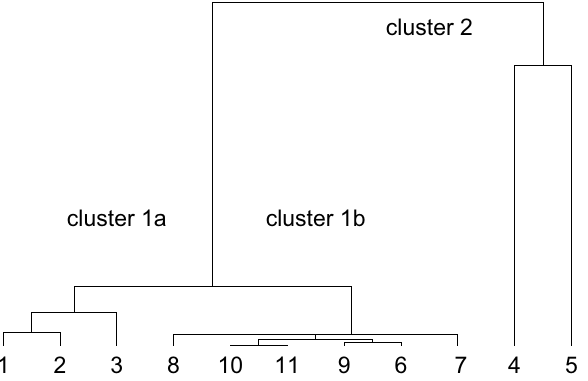
Figure 1. Dendrogram of the hierarchical clustering of the value pairs { α , κ } for the 11 epidemics; two main clusters 1 and 2 are indicated, and within cluster 1 the two (sub)clusters 1a and 1b could be